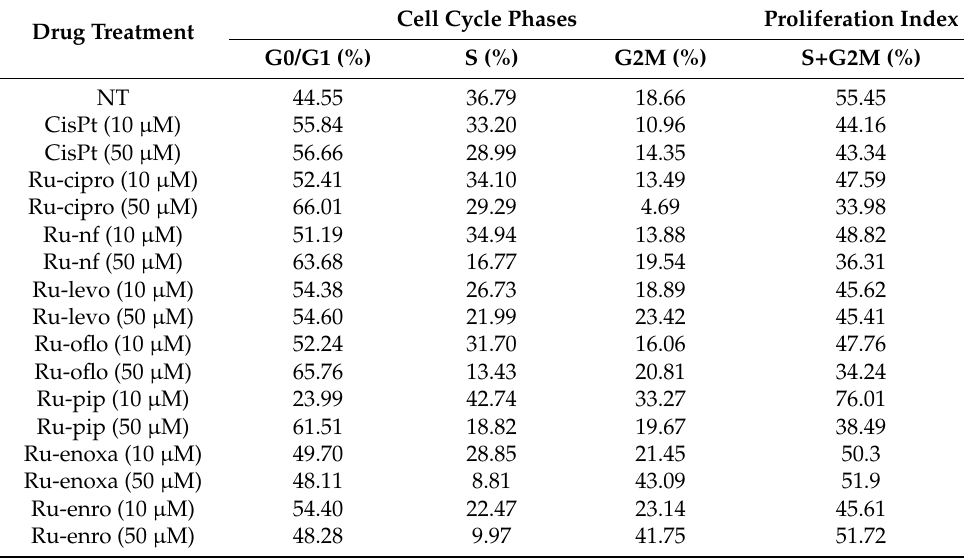
Figure 6. Effects of Ru(III) complexes on DNA progression through LoVo cell cycle phases. Cell cycle phases were analyzed in LoVo human colon adenocarcinoma cell line after cell treatments with 10 µ M ( (cid:3) ) or 50 µ M ( (cid:3) ) Ru(III) complexes or CisPt. DNA progression through cell cycle phases was evaluated after RNase treatment and PI labeling, which was followed by flow cytometry acquisition using a FACS CantoII flow cytometer, and analysis with ModFit software. Negative control (CTRL) was represented by untreated LoVo cells. Table 3. Evaluation of DNA progression through LoVo cell cycle phases treated either with Ru(III) complexes or